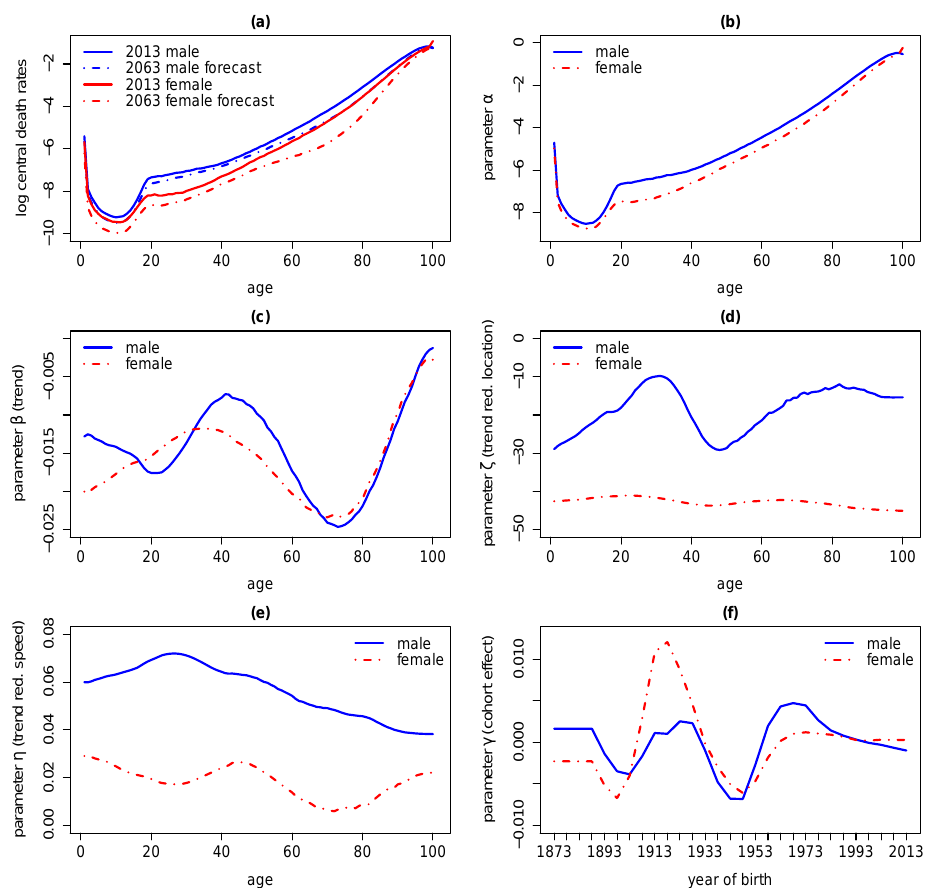
Figure 3. Logarithm of death central death rates ( a ) for 2013 and forecasts for 2063 in Australia as well as parameter values for α , β , ζ , η and γ in subfigures ( b ), ( c ), ( d ), ( e ) and ( f ),